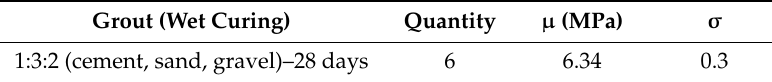
Table 4. Grout compressive strength test results [39].